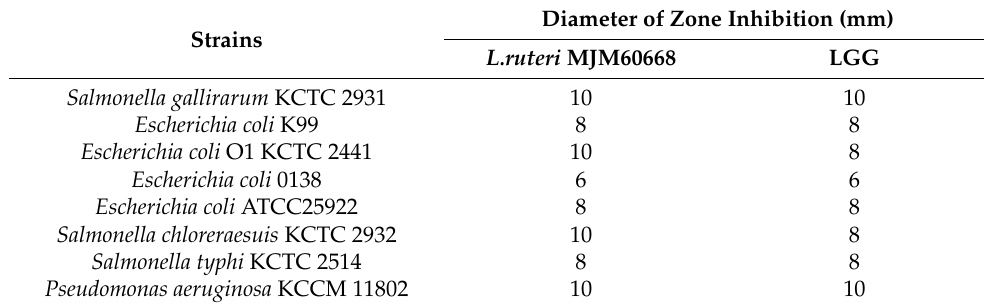
Table 3. Antibacterial activity of L. reuteri MJM60668 and L. rhamnosus GG. Diameter of Zone Inhibition (mm) Strains